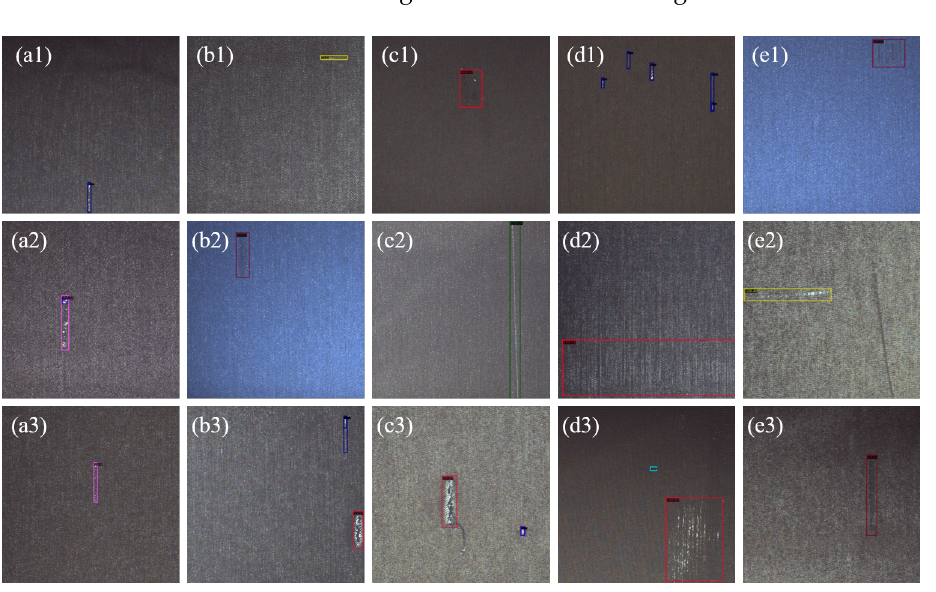
Figure 13. A partial visual result of the fabric defect detection. In each fabric image, the color boxes are the predicted bounding boxes. The color of the box represents the defect of the specified category. Among them, sub-images (a1, d1, a2, b2, c2, a3, b3, c3, e3) are warp defects; sub-images (b1, d2, e2) are weft defects; sub-images (c1, e1, d3) are regional